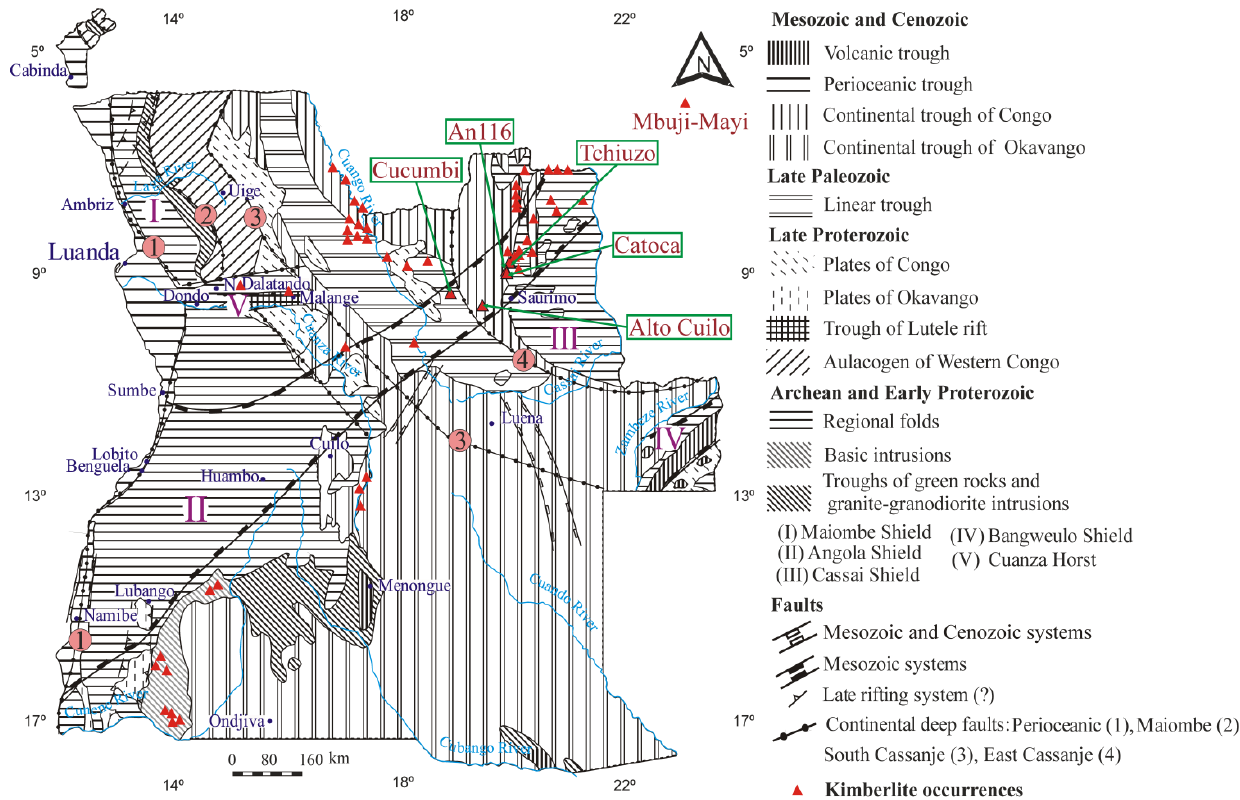
Figure 1. Geological setting of the northeastern Angola kimberlites of this study